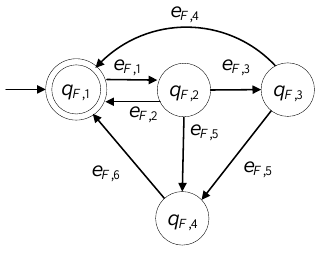
Figure 7. State diagram of